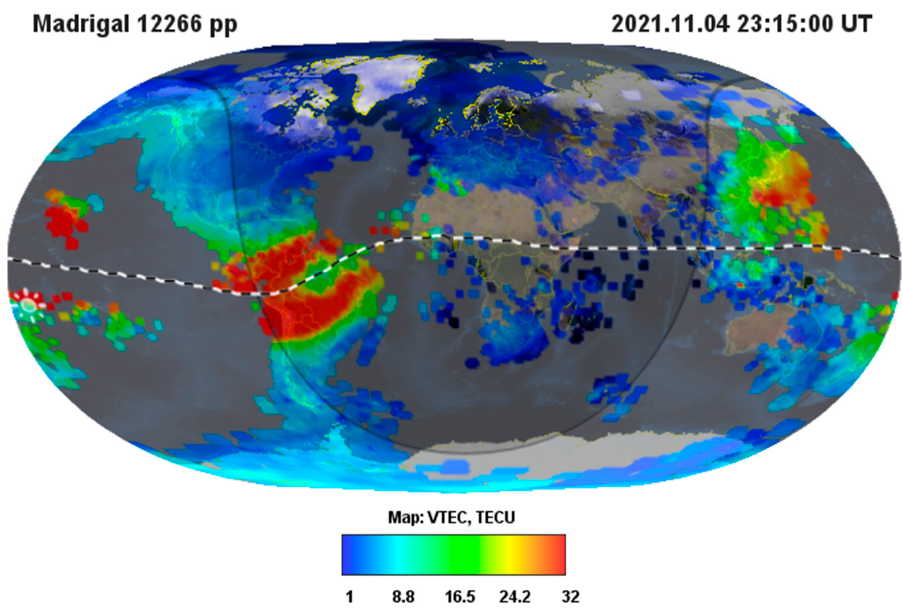
Figure 2. Global high-resolution Vertical TEC map produced using individual GNSS VTEC values at 12,266 pierce points by 4911 receivers (courtesy MIT Madrigal database [27]). The gray color denotes areas of missing sensor coverage; the dashed line is the magnetic equator; the shaded area is nighttime.